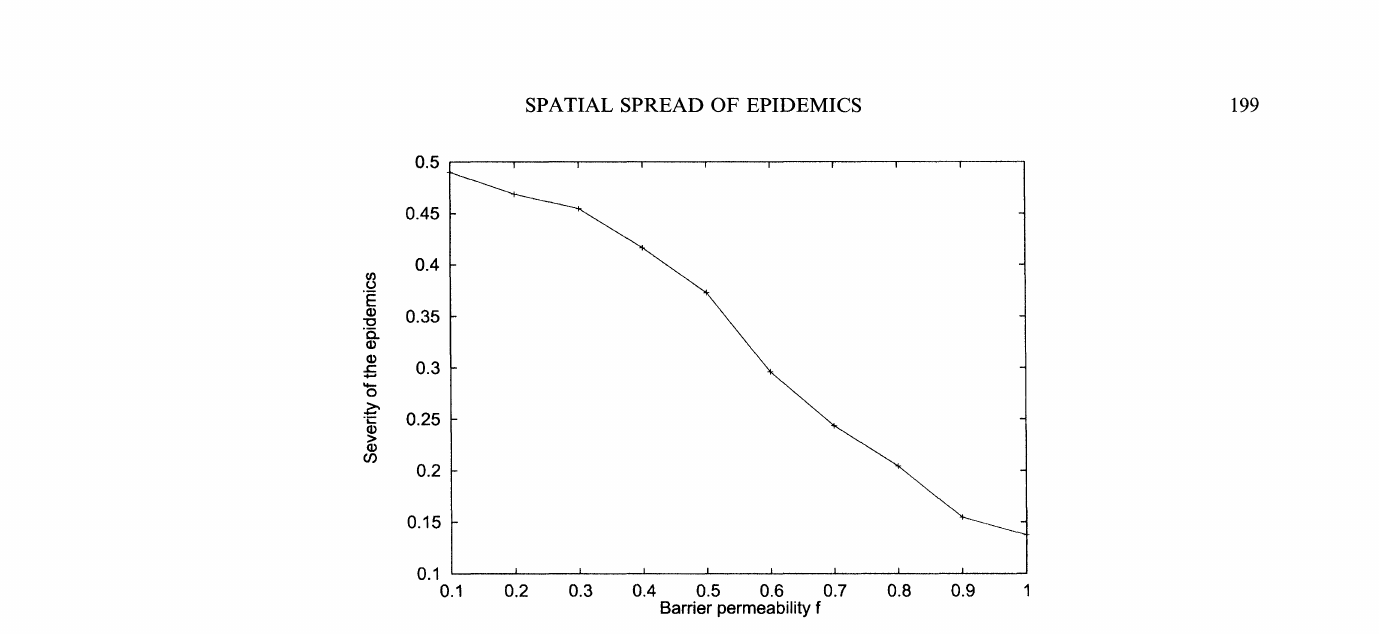
FIGURE 5 Average severity of epidemics of an infectious disease (NR()- NR(O)/Ntot), calculated as average over seventies of outbreaks of epidemics of the disease, as a function of barrier permeability f. For each f the average (.) has been taken over 100 LGCA simulations of outbreaks of epidemics, each starting with identical initial configuration, and 0.3 and a